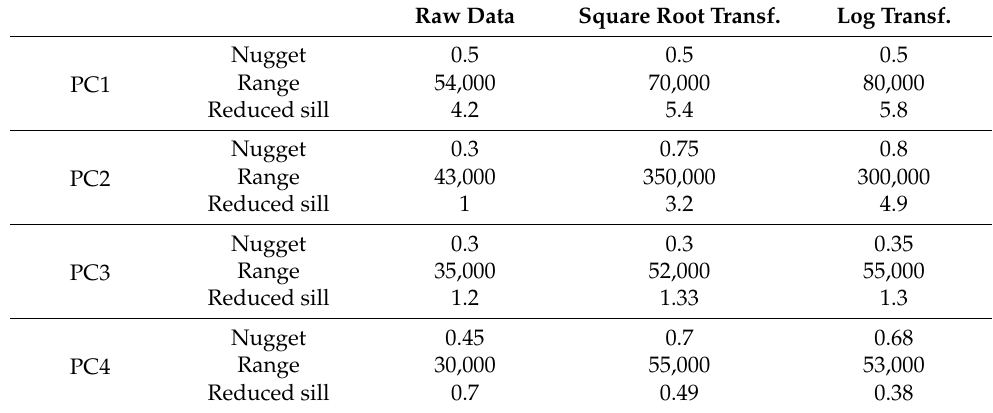
Table 4. Characteristics of the spherical models fitted on the experimental variograms. Raw Data Square Root Transf. Log Transf. Nugget PC1